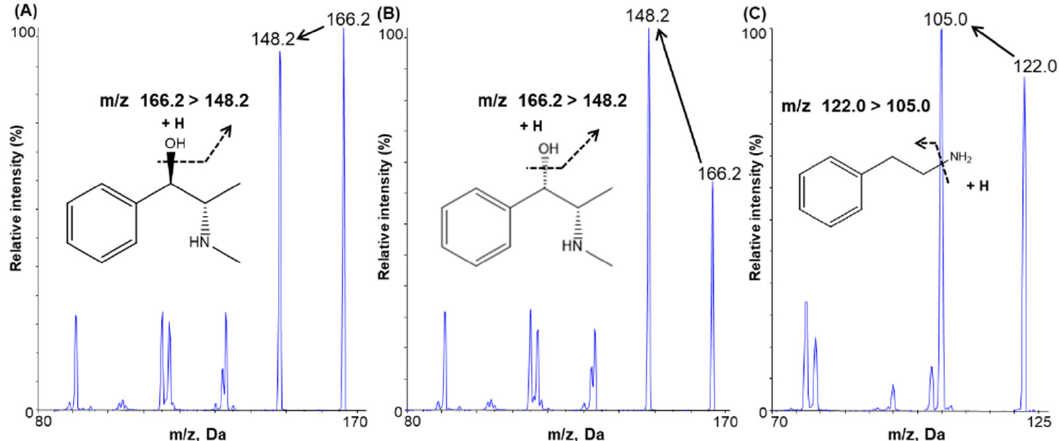
Figure 1. Product ion mass spectra and the pattern of fragmentation of ( A ) ephedrine, ( B ) pseudoephedrine, and ( C ) 2-phenylethylamine (internal standard).